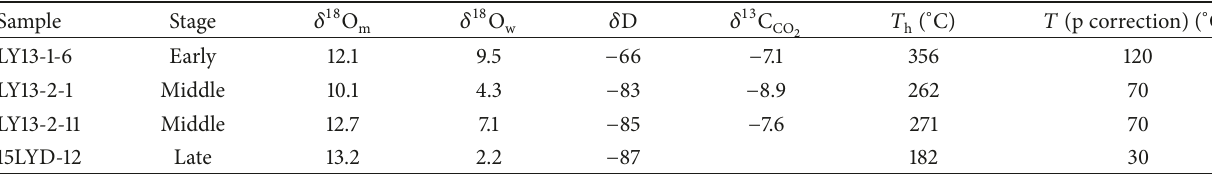
Table 2: The 𝛿 18 O m , 𝛿 18 O w , and 𝛿 D data (‰) of the Liyuan gold deposit.